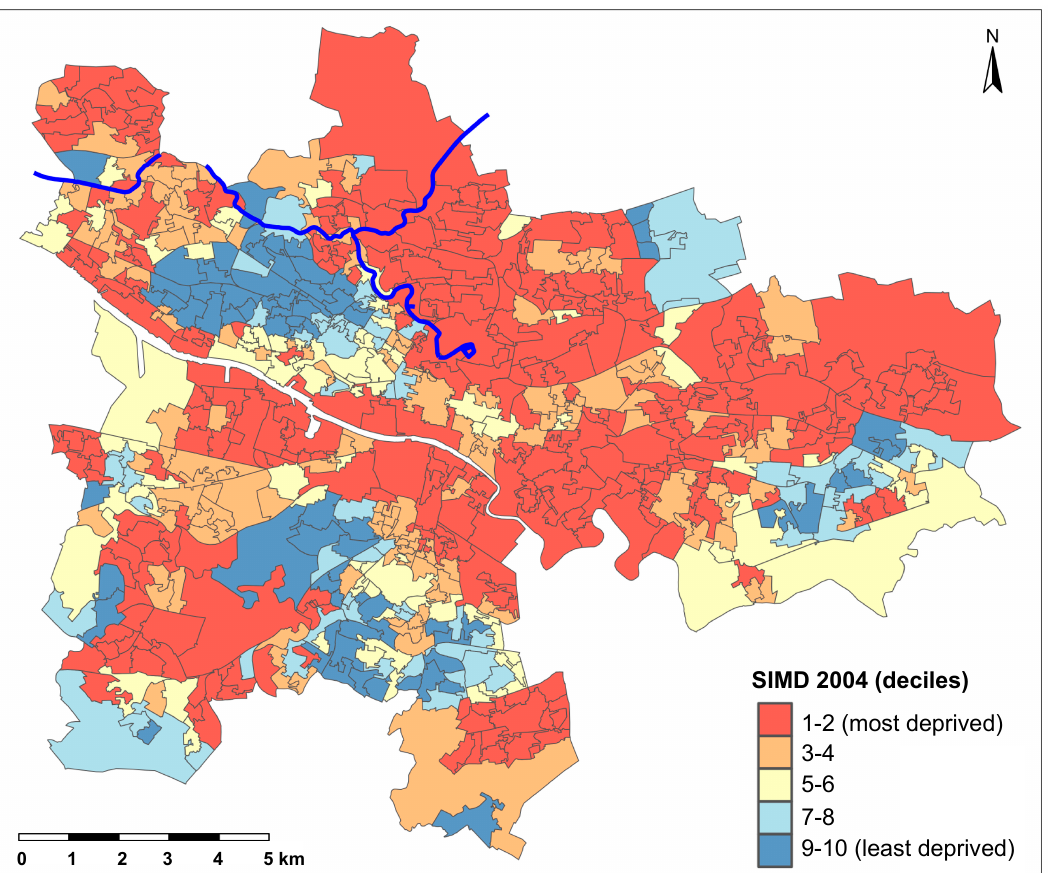
Figure 2. Glasgow city data zones by Scottish Index of Multiple Deprivation (SIMD) 2004 deciles, which relates to the years 2001–2003 (i.e., start of the study period). The blue line depicts the Glasgow canal.